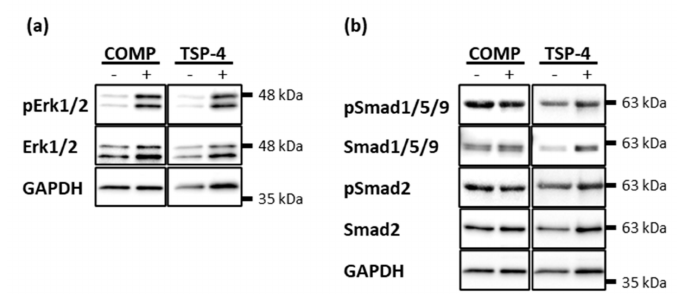
Figure 5. Erk and Smad phosphorylation in chondrocytes after stimulation with COMP and TSP-4. Chondrocytes were stimulated with 10 µ g/mL COMP or TSP-4. Cell extracts were harvested and Smad as well as Erk proteins detected by immunoblot. ( a ) Representa- tive immunoblots showing the detection of pErk1/2 and total Erk1/2. ( b ) Representative immunoblots showing the detection of pSmad1/5/9, Smad1/5/9, pSmad2 and Smad2. GAPDH was used as a loading control; ( n = 4).